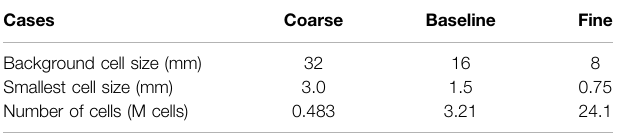
TABLE 1 | Summary of grid sensitivity study: background cell size, smallest cell size and the number of cells in the unit of million control volumes.